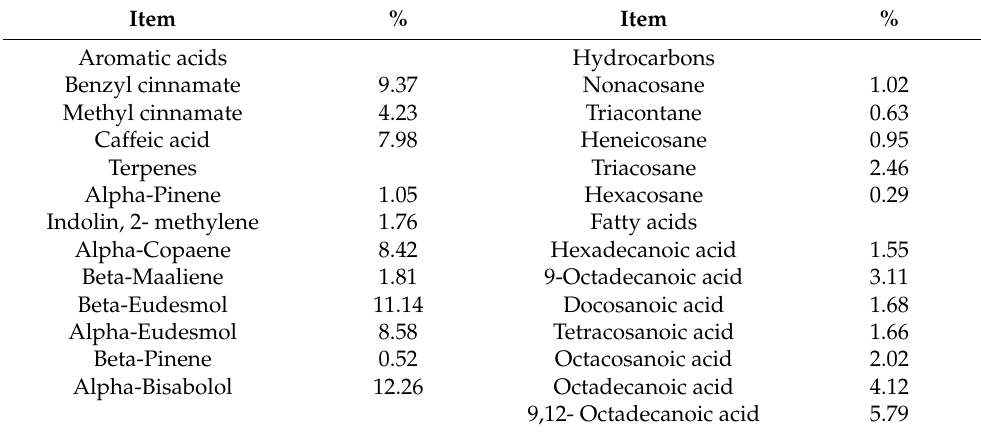
Table 1. Chemical composition of the ethanol extract of